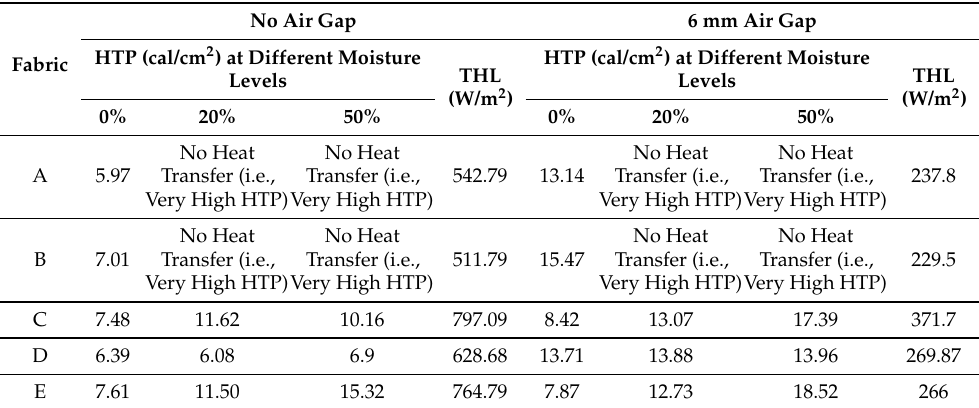
Table 2. HTP and THL values of the selected